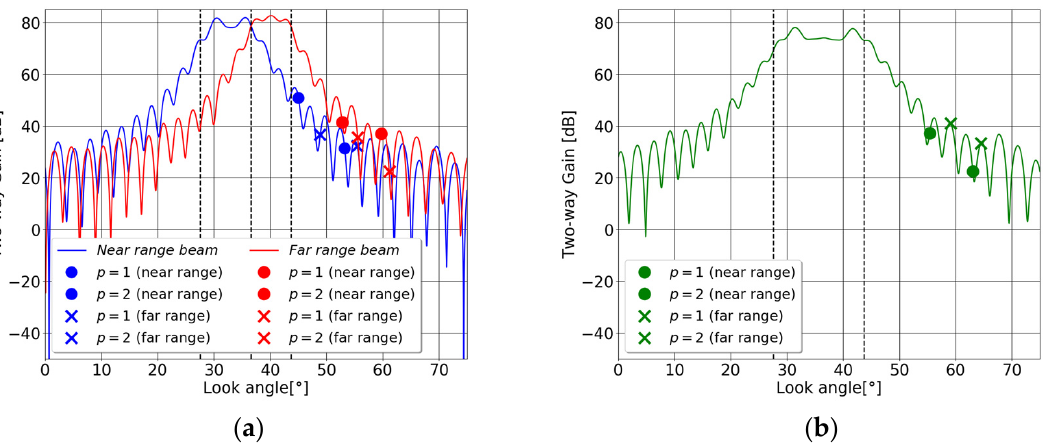
Figure 2. Achieved sector beams in elevation: ( a ) two beams, which cover 120 km ground swath each, and ( b ) one beam, which covers 240 km ground swath as function of look angle. The look angle span between near and far range is highlighted for each beam. The positions of the range ambiguities of the scatterer at near range (circle marker) and of the scatterer at far range (x marker) are shown.